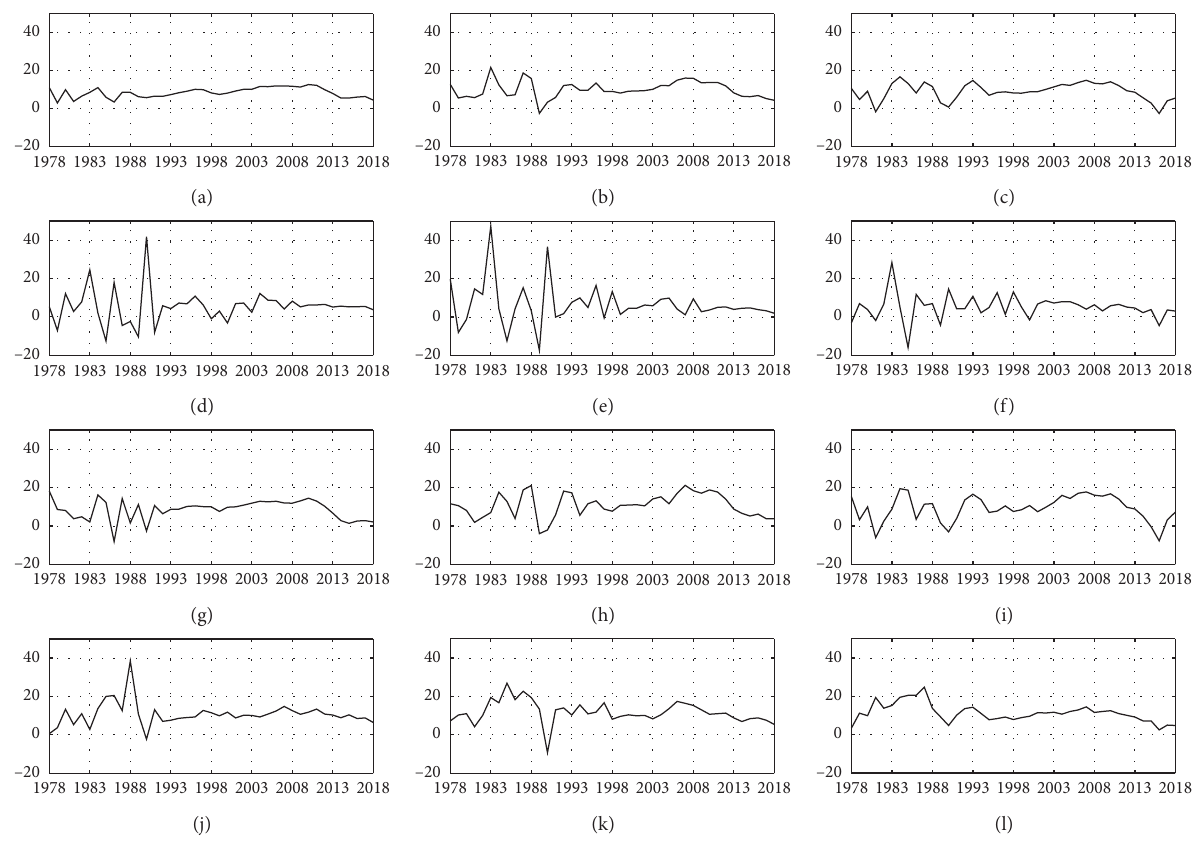
Figure 1: Fluctuation curves of GDP growth rate and value added of each industry in the three provinces: (a) GDP of Heilongjiang, (b) GDP of Jilin, (c) GDP of Liaoning, (d) primary industry of Heilongjiang, (e) primary industry of Jilin, (f) primary industry of Liaoning, (g) secondary industry of Heilongjiang, (h) secondary industry of Jilin, (i) secondary industry of Liaoning, (j) tertiary industry of Heilongjiang, (k) tertiary industry of Jilin, and (l) tertiary industry of Liaoning.